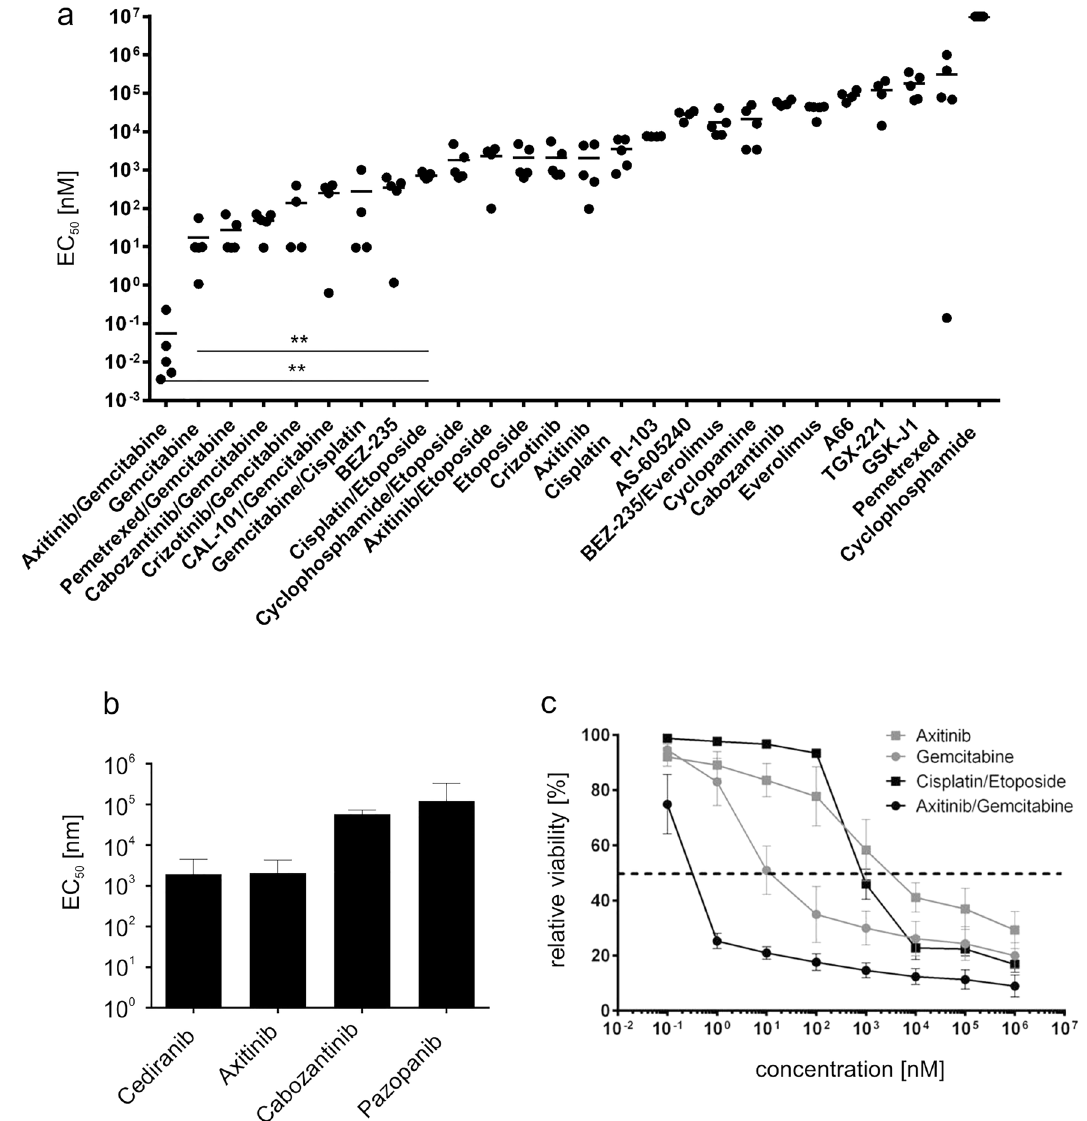
Figure 2. Cytotoxic effect of various cytostatic drugs and inhibitors in vitro. ( a ) MB3W1 cells were treated in vitro with various cytostatic drugs and inhibitors for 48 h before staining with annexin V/Live-Death-staining and flow cytometry analyses. Graph shows the respective EC50 –values (Mean ± SD; combined data from five independent experiments; **, p = .0079) ( b ) EC50 –values for a panel of inhibitors of the VEGFR. ( c ) Relative cell viability after cisplatin/etoposide phosphate, gemcitabine, axitinib and gemcitabine/axitinib treatment and corresponding EC50 (dotted culture conditions and grows differently: Particularly MB3W1 cells are cultured in serum-free conditions, using stem cell medium. The cells grow as spheres with dying cells floating predominantly outside the spheres as single cells. The other cell lines were cultured in medium containing fetal calf serum (FCS), which leads to adherent or at least semi-adherent growth. In order to be able to better compare cytostatic effects, the cells lines HDMB3, D341-MED (group 3) and CHLA-01R (group 4) were gradually weaned off FCS-containing serum and grown in the same FCS-free stem cell medium as MB3W1. The DAOY cell line did not tolerate serum-free conditions. Cells changed their growth behavior, growing non-adherently in spheres similar to MB3W1. We then repeated in vitro assays with these cell lines and assessed the degree of apoptosis after 72 h and 96 h of incubation with either control solvent, gemcitabine, axitinib or the mixture of both. Gemcitabine at a concentration of 100 nM was cytotoxic to all the cell lines, and sub-maximal cytotoxicity was seen at 10 nM , although D341 cells were still very sensitive to monotherapy. HDMB3 responded better than under FCS-conditions, but required a dose of 100 nM. Axitinib in contrast was only active at the micro-molar range, when used as monotherapy in this in vitro setting, as had been established before. However, effects of axitinib on the more resistant cell lines HDMB03 and CHLA-01R were more pronounced under serum-free conditions. For combination treatment in this setting, we chose a suboptimal gemcitabine dose (10 nM) and asked how an optimal axitinib dosing added to cytotoxicity.